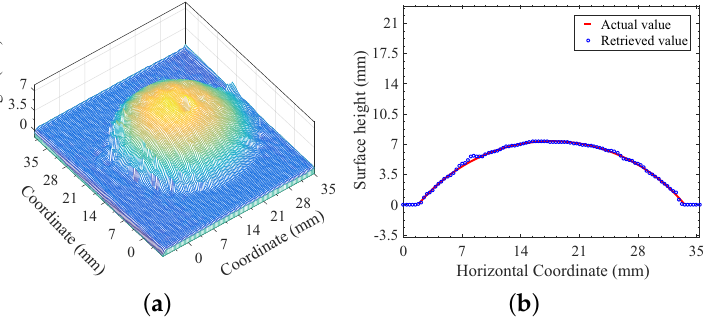
Figure 4. Reconstruction of the spherical cap of vulcanized silicone rubber: ( a ) reconstruction using the measurement of Figure 3c; and ( b ) error of reconstruction.